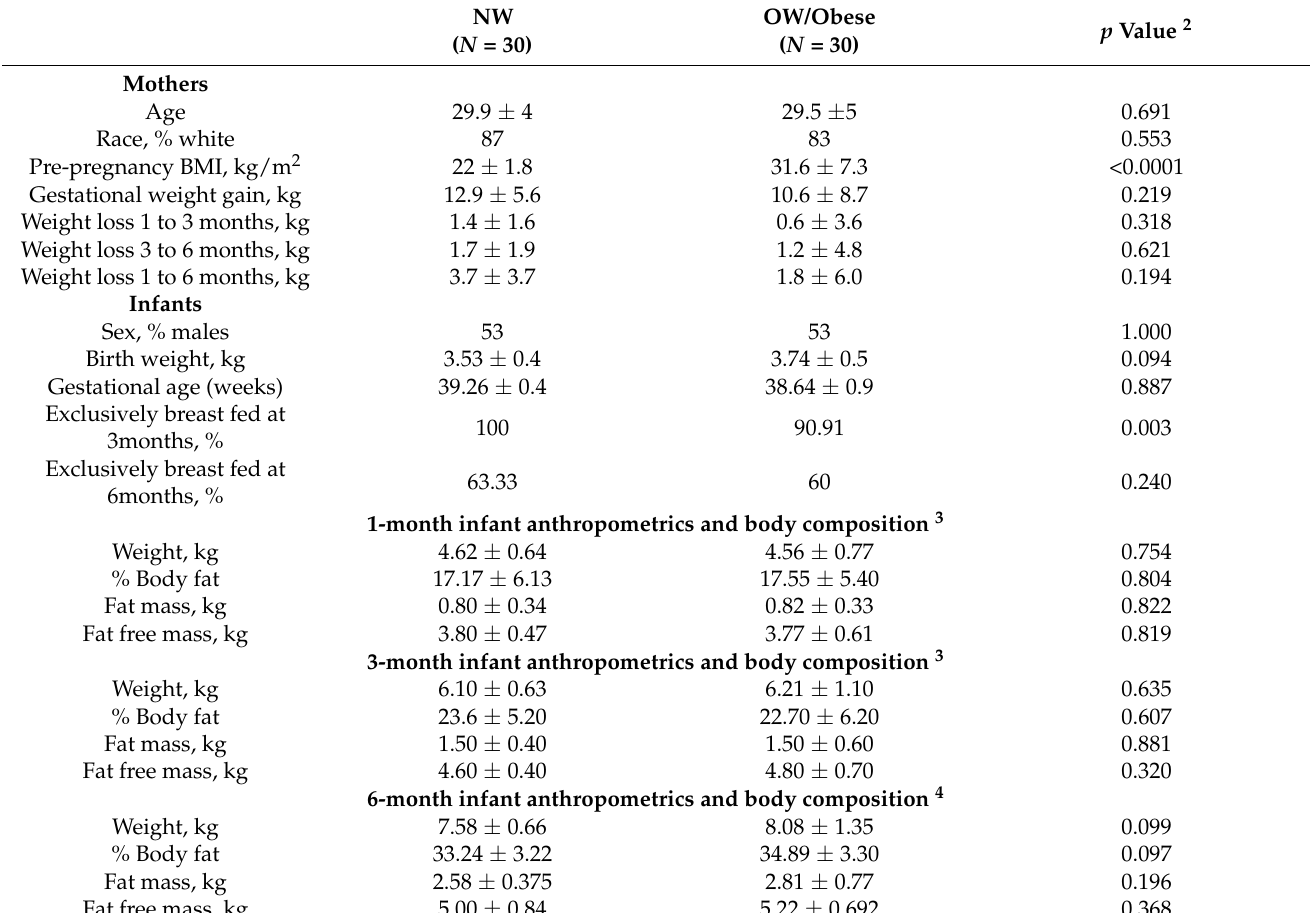
Table 1. Maternal and Infant Characteristics 1 .